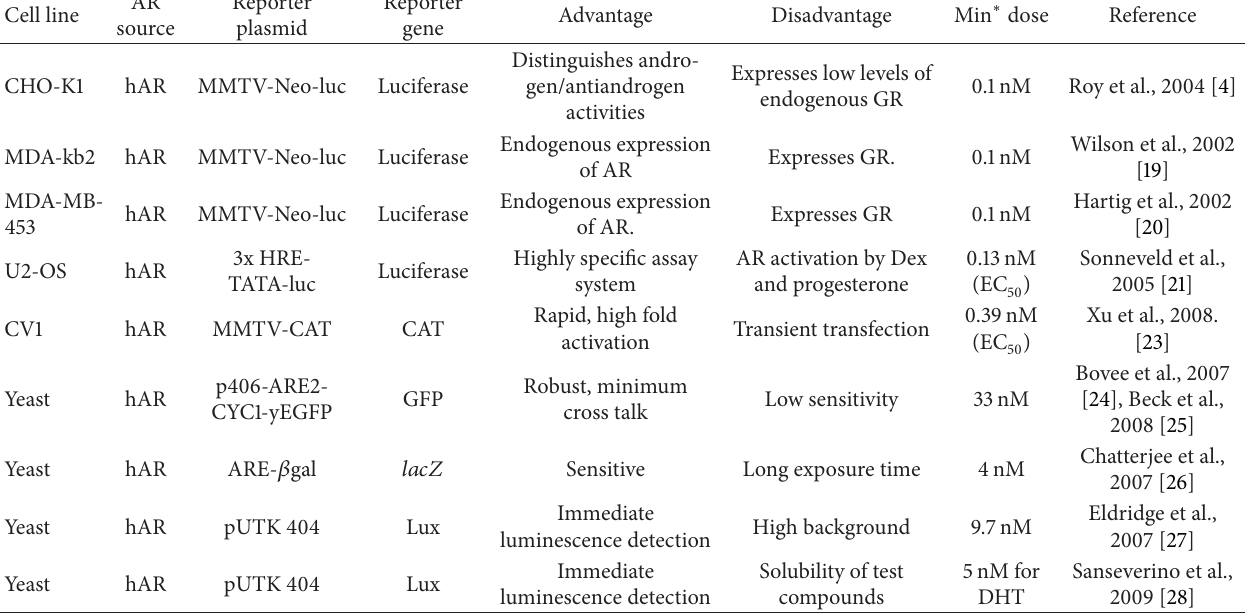
Table 3: Comparative analysis of in vitro reporter systems in mammalian and yeast